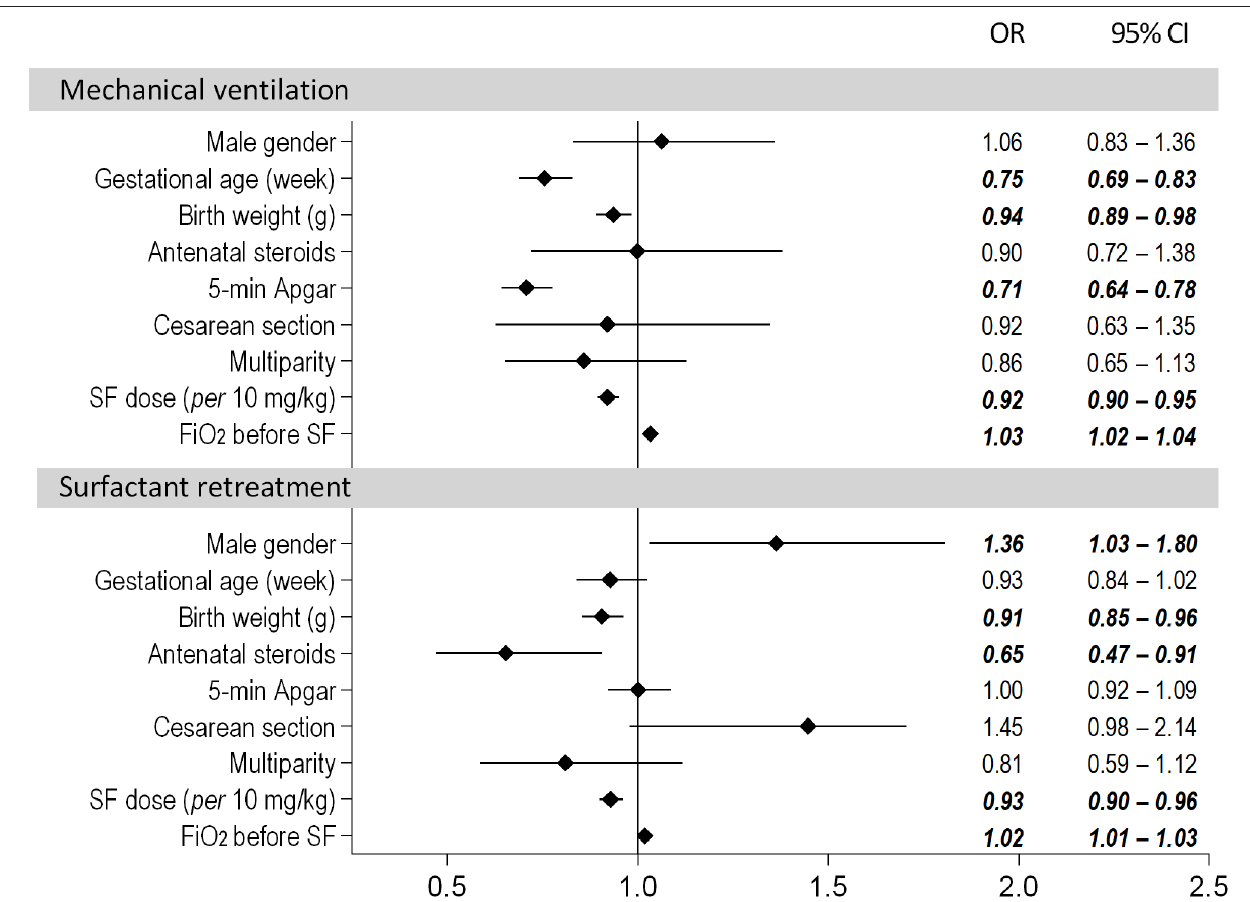
FIGURE 1 | Results of the multivariate logistic regression model assessing the need for mechanical ventilation and surfactant retreatment. The dose of poractant alfa was used as a continuous variable. most premature infants < 26 weeks gestation (median deviation − 3 mg/kg). As shown in Figure 2 , median underdosing increased with gestational age and equaled